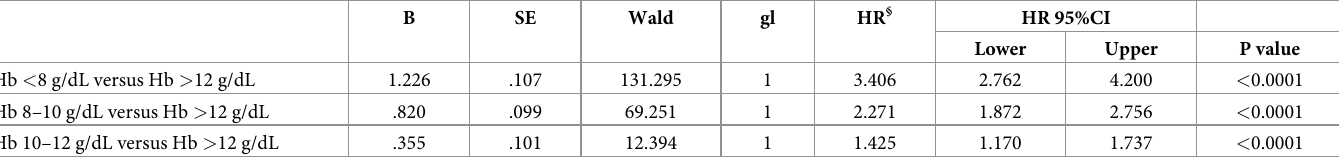
Table 7. Multivariate model for overall survival at 1 year.